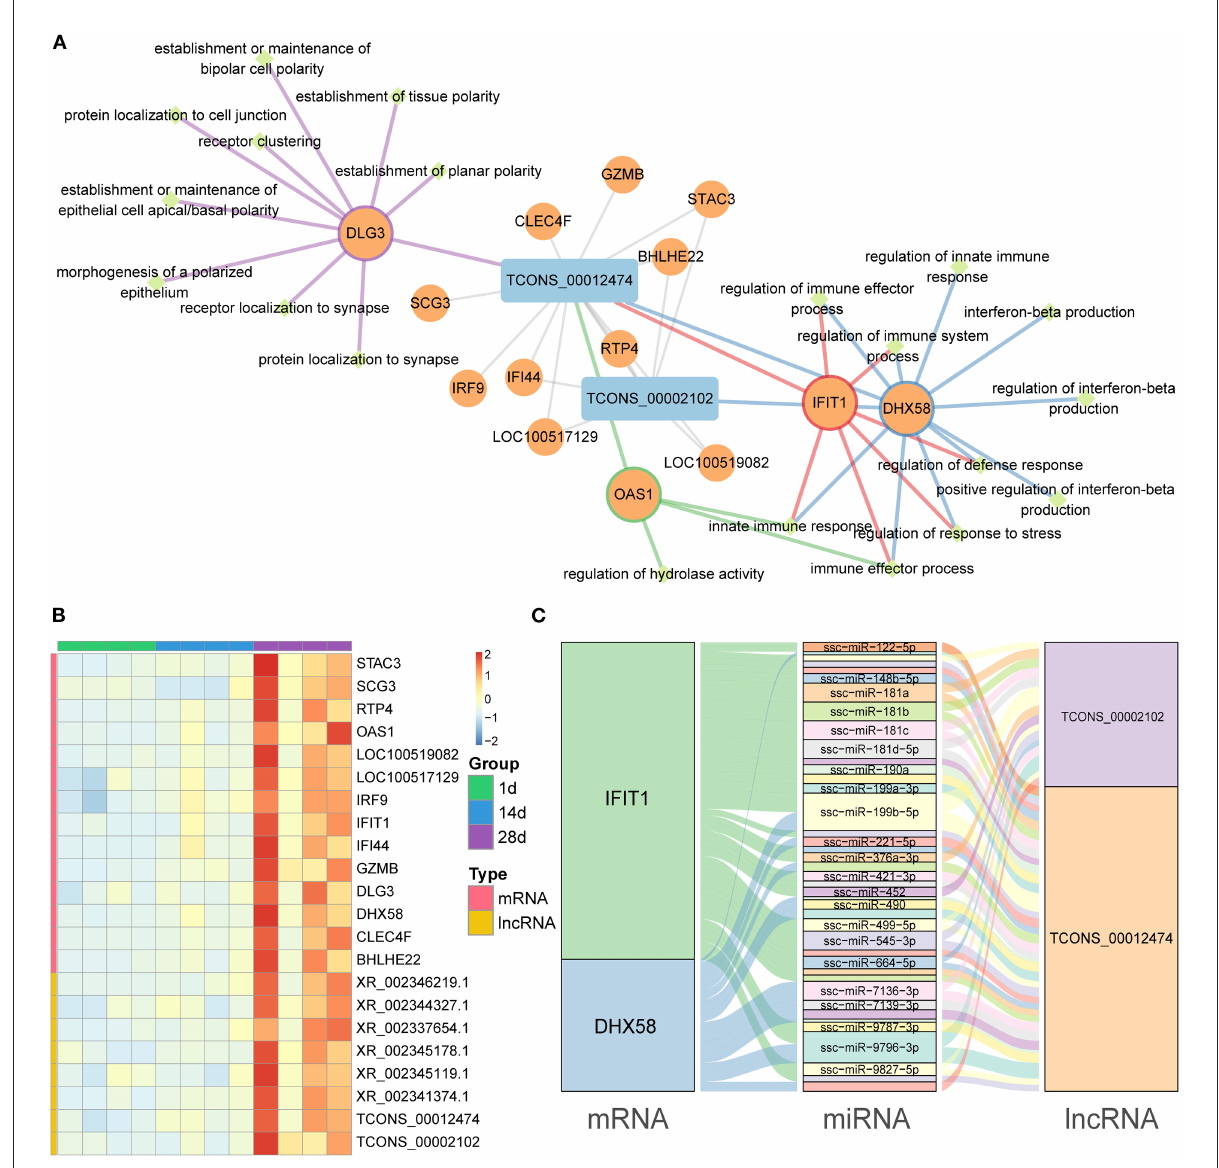
FIGURE6 mRNA–lncRNA co-expression networks and ceRNA networks. (A) Co-expression mRNA–lncRNA network in the red and black modules. The circular nodes represent the mRNAs, and the triangle nodes represent lncRNAs. Gray edges represent mRNA–lncRNA interactions and the other edges represent the mRNA pathways. (B) Heat map showing the correlated expression of mRNA and lncRNA in spleen tissue at three different ages. (C) ceRNA network shows the relationship between mRNA, miRNA, and lncRNA.